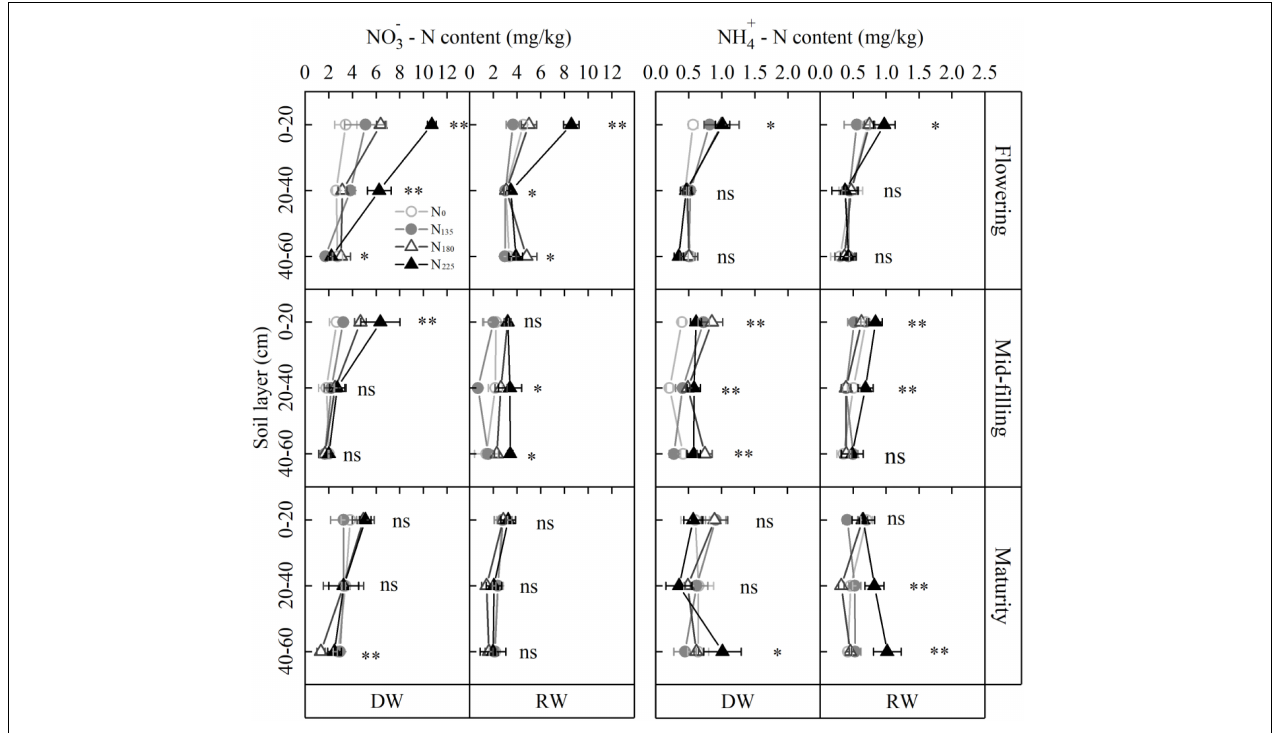
FIGURE 4 | Changes in soil NO 3 − –N and NH 4 + –N content during the late growth stage of wheat under dryland wheat (DW) and rice stubble wheat (RW) in 2020–2021. * P < 0.05; ** P < 0.01; ns,